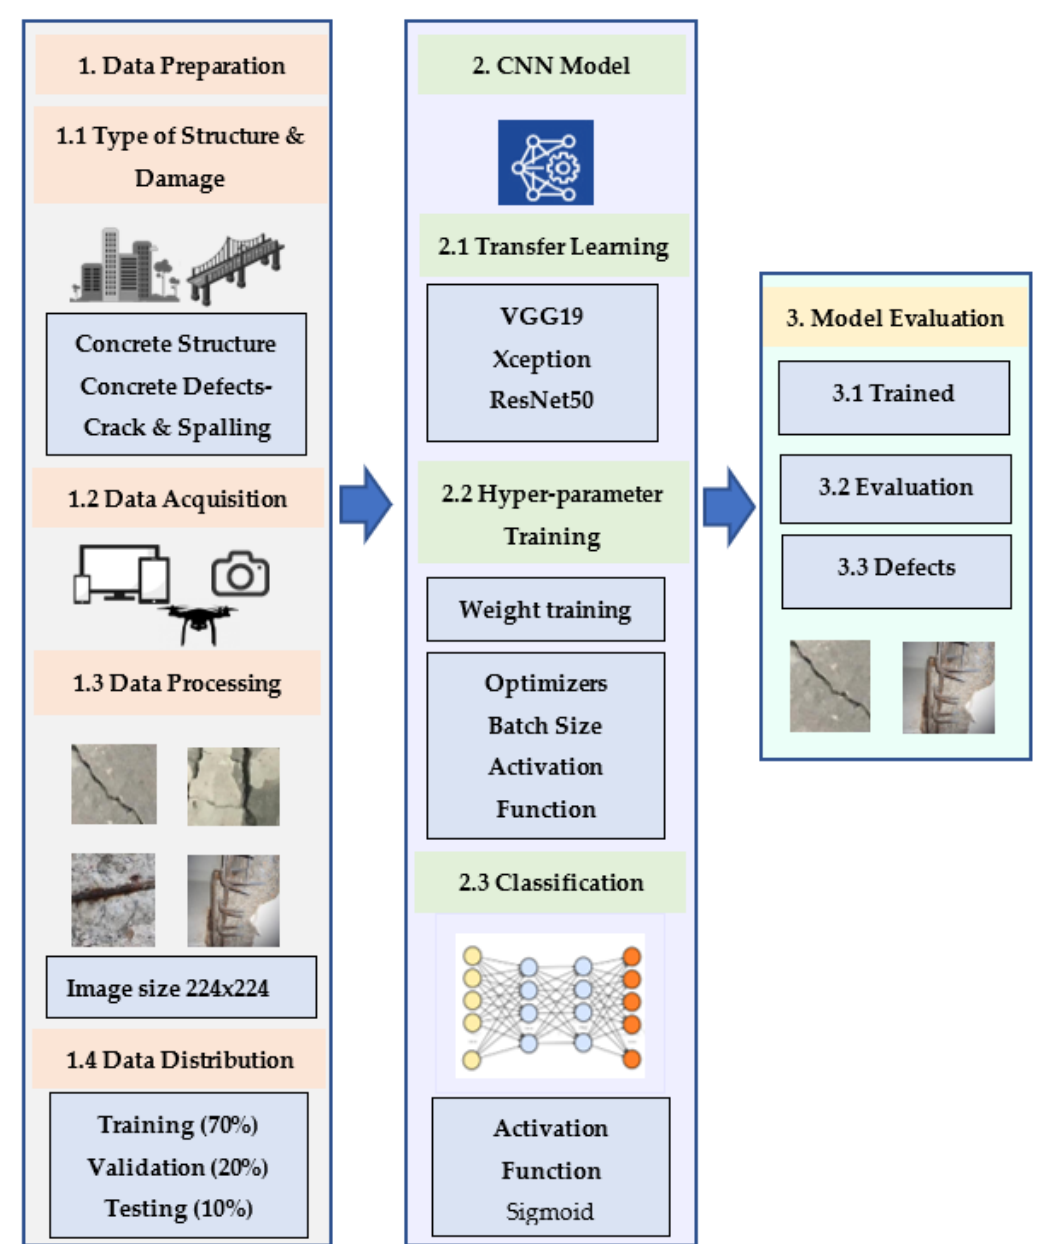
Figure 1. Workflow chart for defects classification.